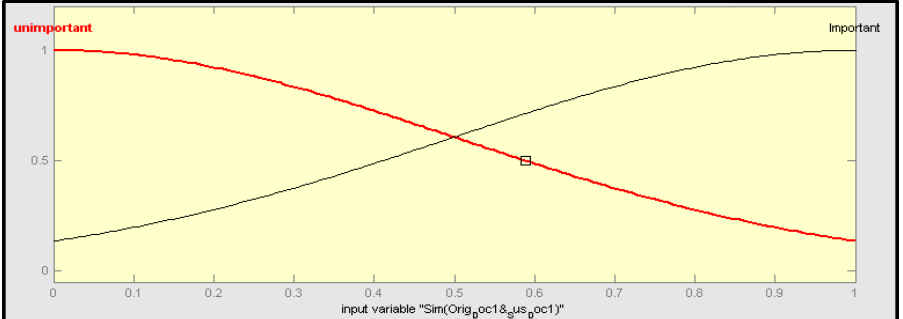
Figure 6. Input MF for fuzzy model.